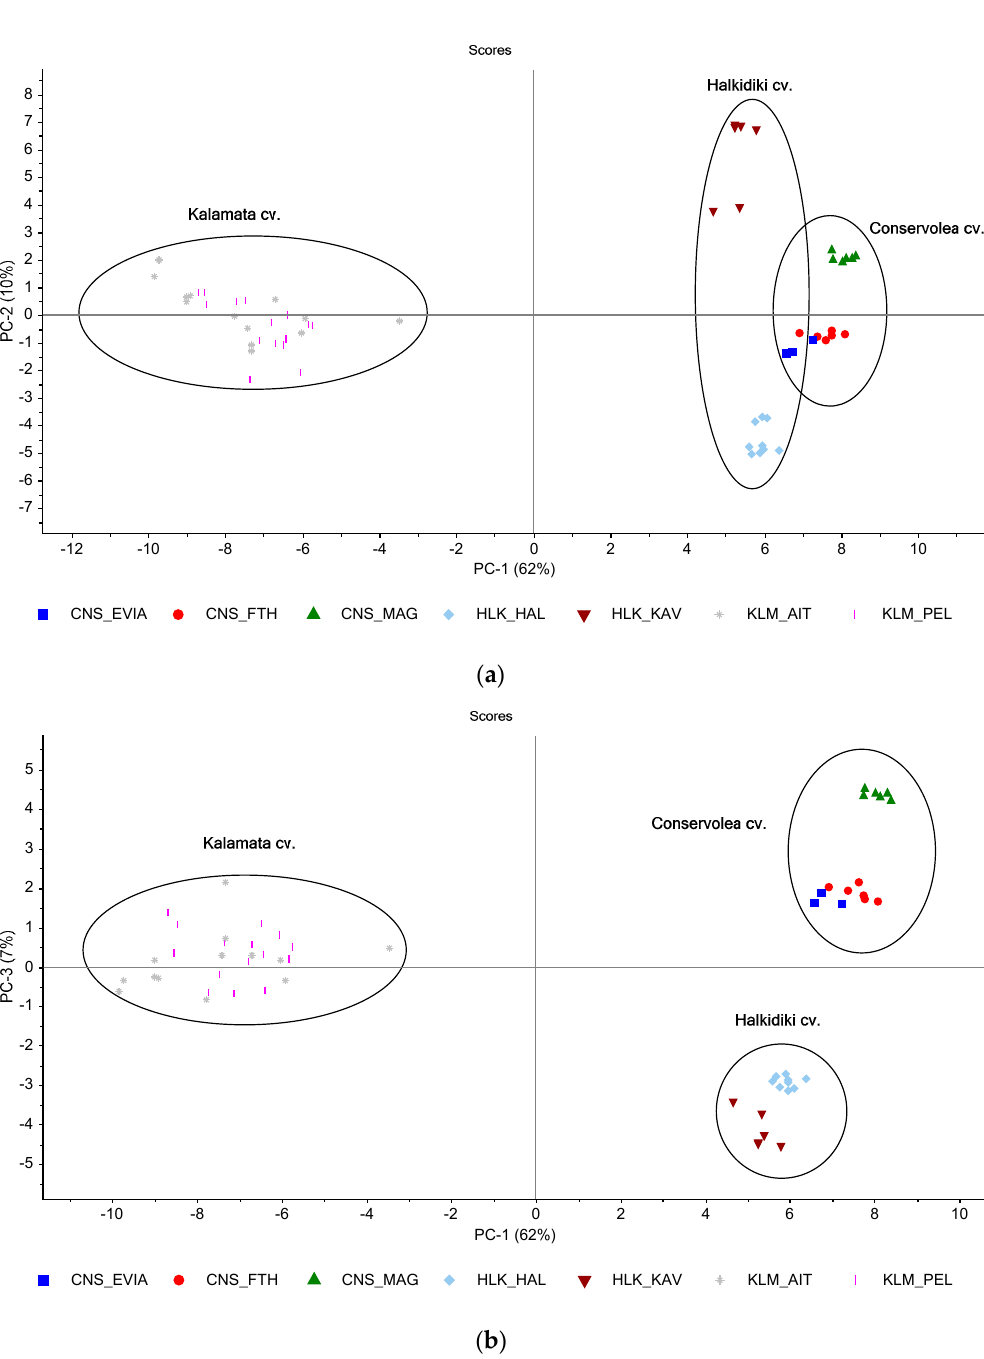
Figure 2. Principal component analysis (PCA) of the volatile compounds identified in industrially fermented table olives from different cultivars (CNS: Conservolea; HLK: Halkidiki; KLM: Kalamata) and growing areas (EVIA: northern Evia; FTH: Fthiotida; MAG: Magnesia; HAL: Halkidiki; KAV: Kavala; AIT: Aitoloakarnania; PEL: Southern Peloponnese): ( a ) PC1 vs PC2; ( b ) PC1 vs PC3.